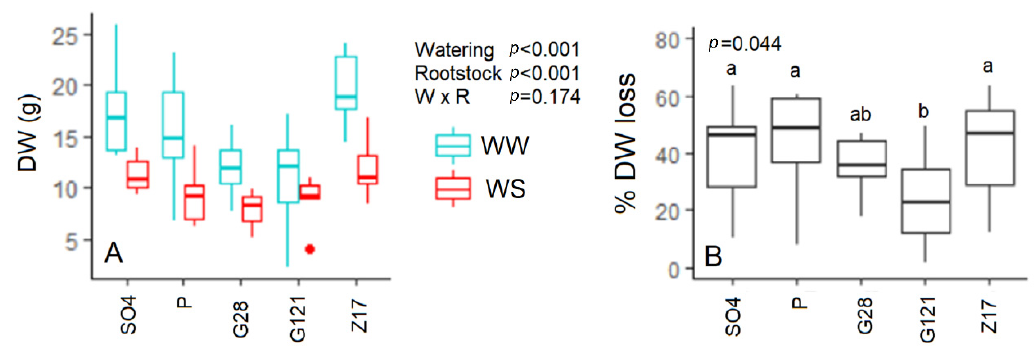
Figure 9. (A ) Biomass above ground dry weight (DW) for the five rootstocks used in this work under well-watered (WW) and water-stress (WS) conditions ( n = 6–9). The p -values from two-way ANOVA are shown in the graph. ( B ) Decrease in DW for WS expressed as % of WW plants. Different letters represent significant differences according to Fisher’s test ( n = 6–9). The p -value from one-way ANOVA is shown in the graph.